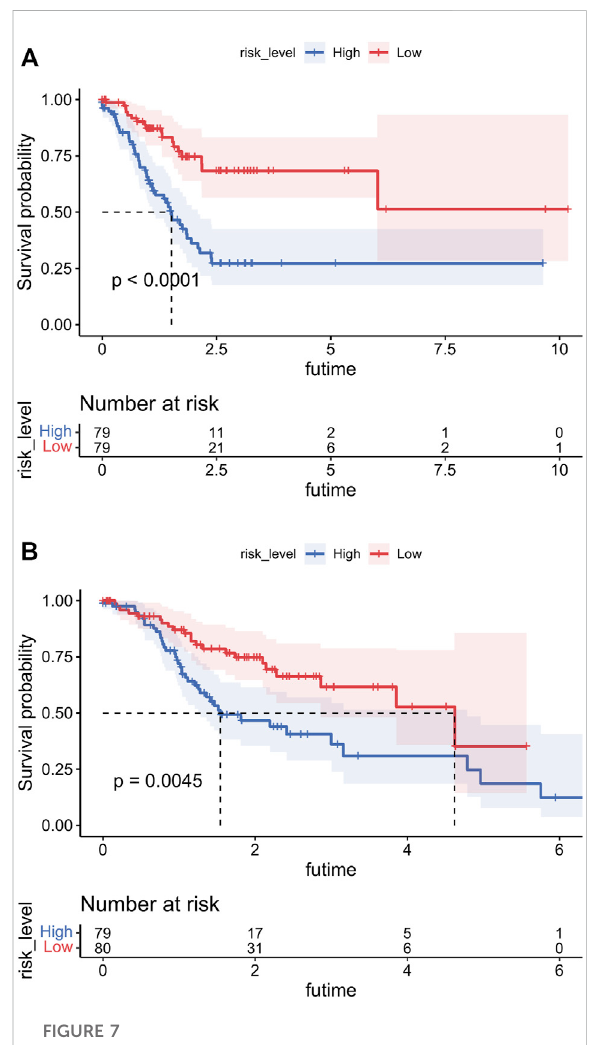
FIGURE 7 Overall survival (OS) Kaplan – Meier curves for patients in the low- and high-risk groups. (A) Training cohort. (B) Internal validation